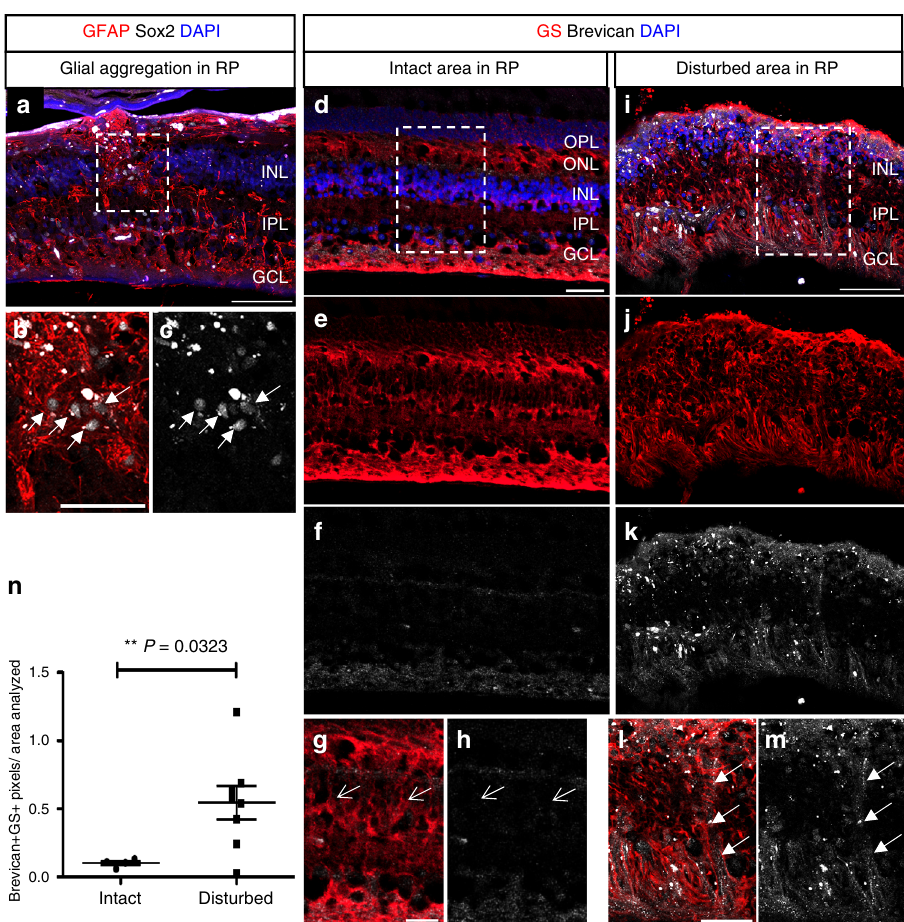
Fig. 7 Brevican in MG of disorganized human retinitis pigmentosa retinas. a – m Immuno fl uorescence for Tomato, GFAP, and Sox2 ( a – c ) or glutamine synthetase (GS) and Brevican ( d – m ), as well as DAPI nuclear staining of retinal cross sections of retinitis pigmentosa patients. Glial aggregations (white arrows in b , c ) found in the INL resemble to those found in the 6-month-old Dicer-CKO MG retinas. MG in intact regions (arrows in g , h ) were Brevican – while glial aggregations found in disturbed regions (arrows in l , m ) were Brevican + . n Brevican/GS immunoreactivity assessed in intact ( n = 4) and disturbed ( n = 8) retinitis pigmentosa samples showed a signi fi cant increase in Brevican protein level in the disturbed samples. Statistics: mean ± S.E.M., independent samples t -test and Levene ’ s test for equality of variances, 2-tailed, p = 0.0323. Scale bars in a , i : 100 μ m, in b , d : 50 μ m in g , l : 25 μ m. ONL, OPL, INL, IPL, GCL, NFL as de fi ned in Fig. 1 legend, RP retinitis